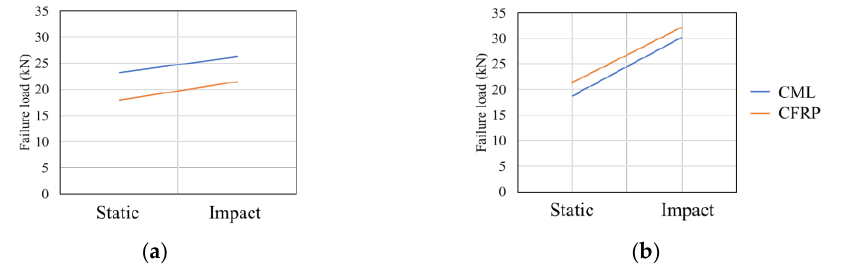
Figure 24. Failure load under quasi-static and impact loading for ( a ) AF 163-2K and ( b ) XNR 6852 E-3. Adapted from [157].